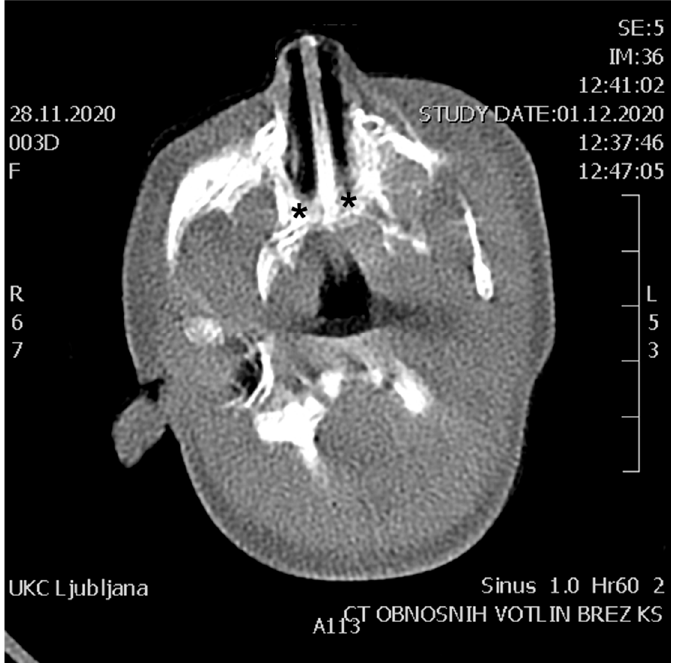
Figure 3. CT of the nose and paranasal sinuses in the axial plane. Bilateral bony choanal atresia is seen in a three-day-old neonate. * indicates atretic plate.